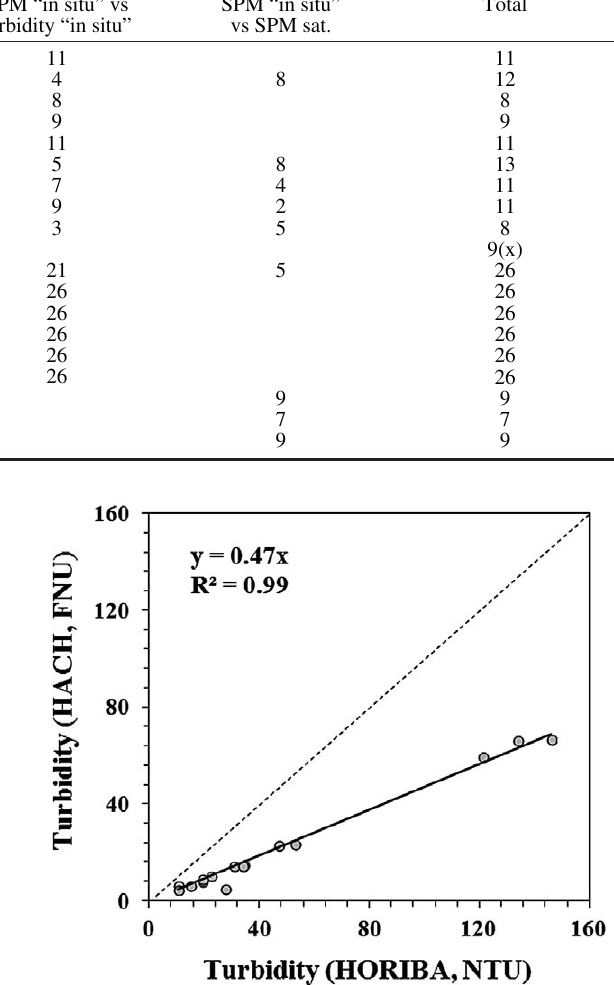
Fig. 2. – Linear relationship between simultaneous measurements of turbidity using HACH 2100P ISO (formazin nephelometric unit, FNU) and HORIBA U-22XD (nephelometric turbidity unit, NTU)